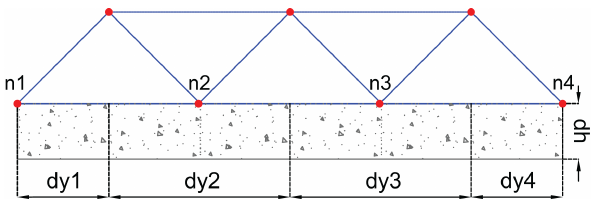
Figure 2. Area and relative height dh of the dissolved salt at the boundary between the fracture and the salt